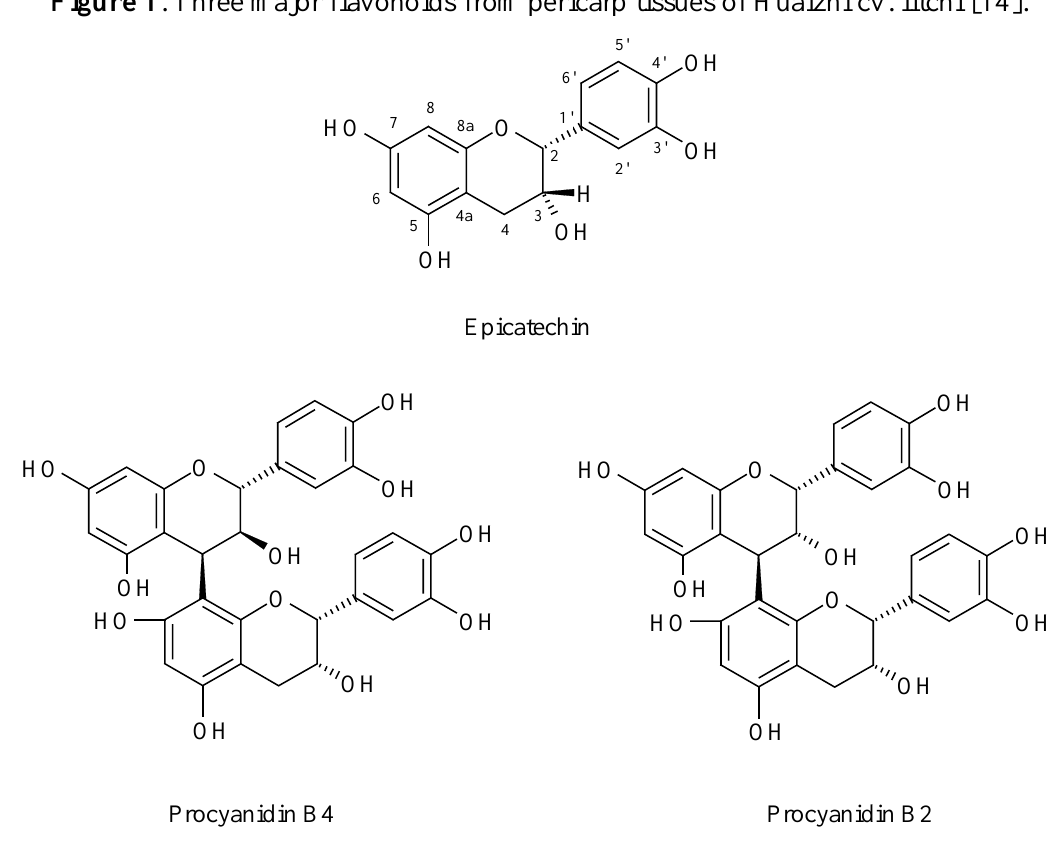
Figure 1 . Three major flavonoids from pericarp tissues of Huaizhi cv. litchi